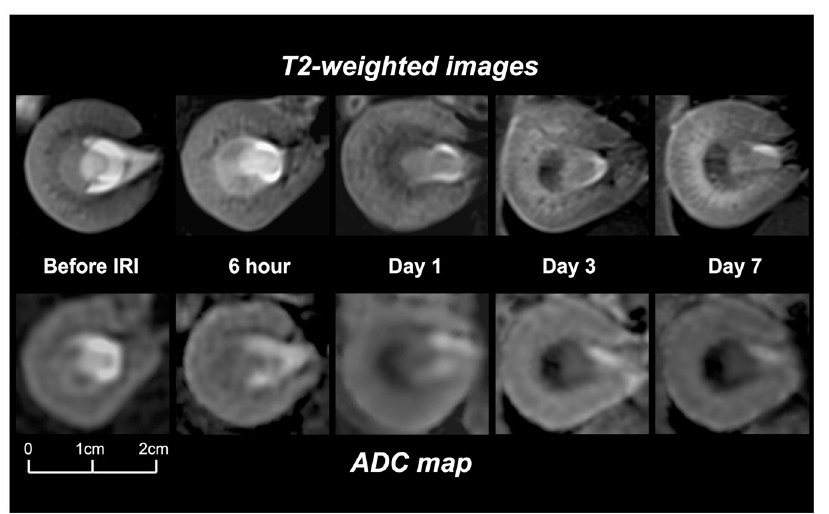
Figure 2. Examples of longitudinal changes of T2-weighted images and ADC maps before and after IRI at 6 hours, days 1, 3, and 7 in a rat kidney. Note subtle changes of the renal cortex, gradual hyperintense changes of OSOM, and progressive hypointense changes of ISOM over time on T2-weighted images. The progression of fluid restriction of ISOM is apparent on ADC